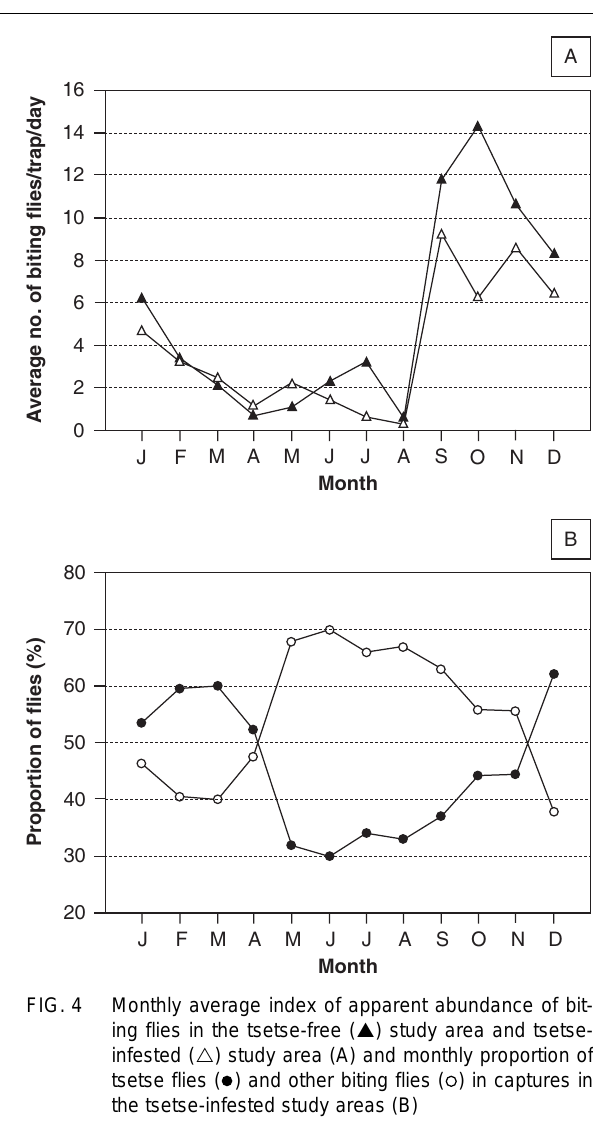
FIG. 4 Monthly average index of apparent abundance of bit- ing flies in the tsetse-free ( (cid:83) ) study area and tsetse- infested ( (cid:85) ) study area (A) and monthly proportion of tsetse flies ( ) and other biting flies ( ) in captures in the tsetse-infested study areas